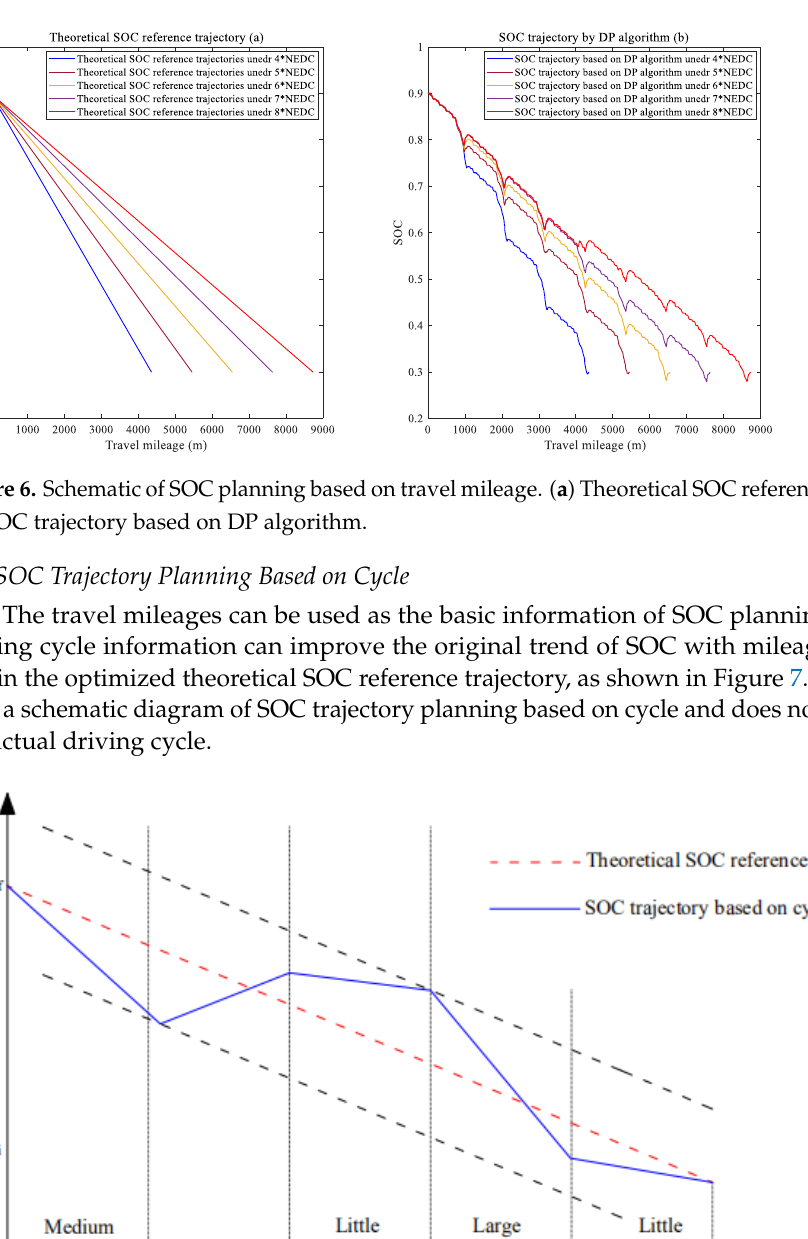
original SOC trend can be improved with the change of travel mileage.